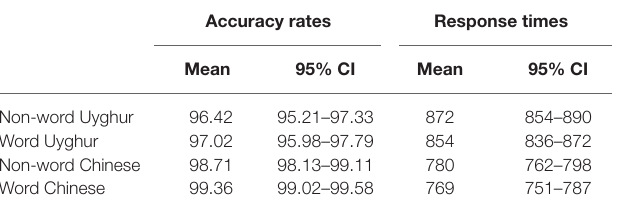
TABLE 2 | Mean accuracy rates in percentage (%), mean response times (ms) of correct trials and the 95% confidence intervals (CI) from the lower bond to the upper bond for the lexical decision task by Word Type and